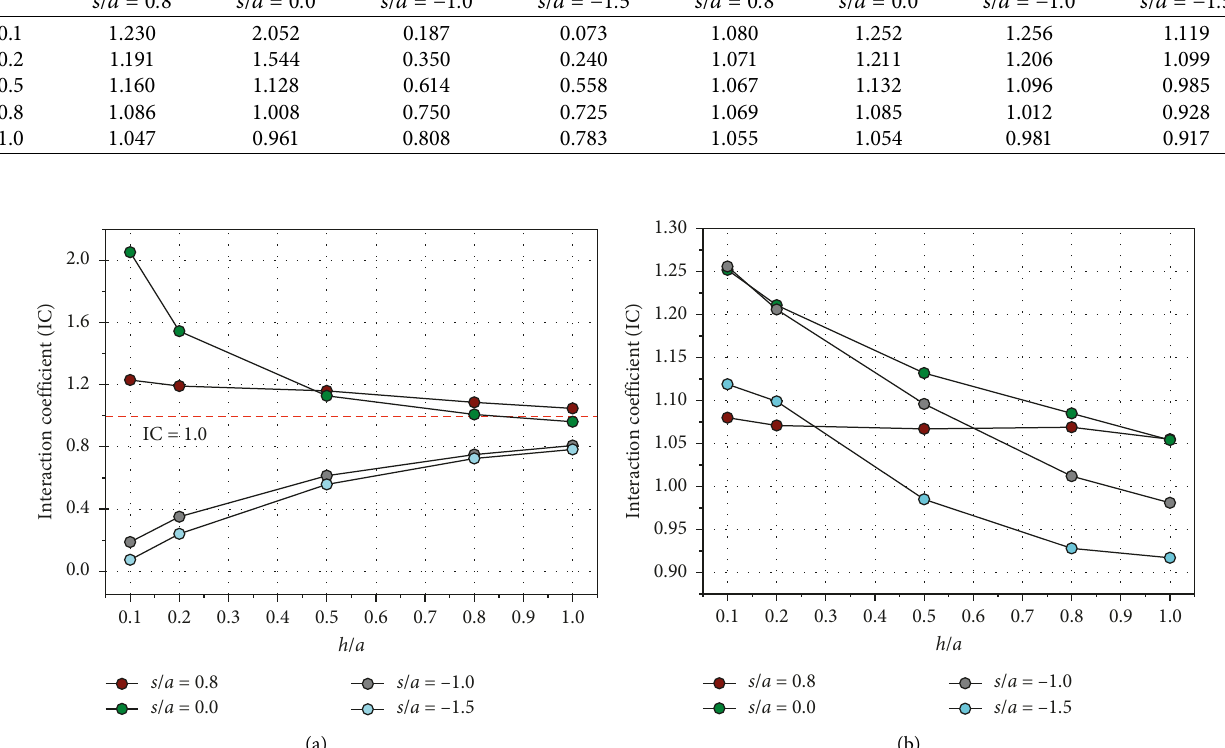
Figure 9: IC variations with staggered distance ratio under unloading conditions. (a) Inner tip (Crack 1). (b) Outer tip (Crack 1). Table 2: ICs varying with length ratio of rock bridge ( s / a ). Inner tip (Crack 1) Outer tip (Crack s / a